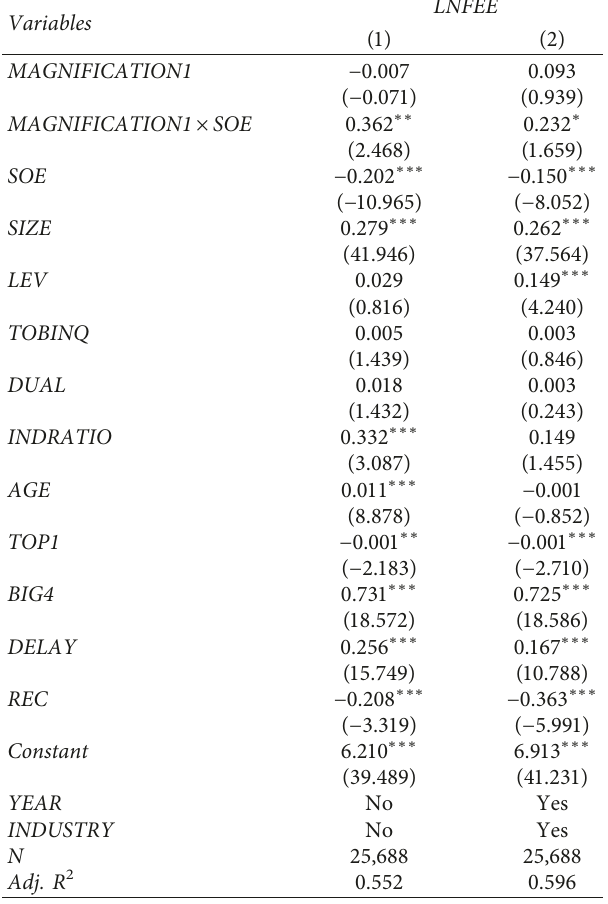
Table 8: Amplification effect and audit fees: effect of the nature of property